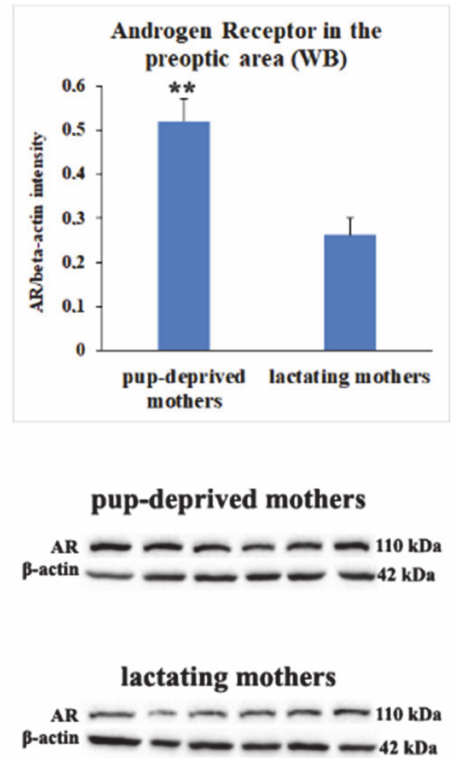
Figure 7. Androgen receptor (AR) protein levels in MPOA of pup-deprived and lactating mothers. Preoptic area was dissected from six pup-deprived and six lactating mothers on the 10th postpartum day. Data are expressed as β -actin intensity ration. Pictures of immunoblot bands are shown below. Western blot results show that AR protein levels are significantly higher in the MPOA of pup-deprived mothers. (** = p <